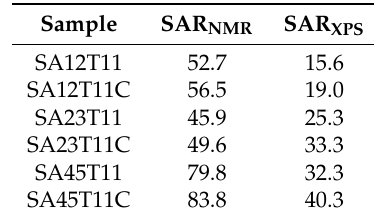
Table 1. SAR calculated using the XPS and HPDEC MAS NMR results of the different Al STF samples (Reprinted from Catalysis Today, v. 2019, P. Vinaches, E. C. Gonçalves, Y. Variani, A. Rojas, E. Rodríguez-Castellón, S. B. C. Pergher, Aluminum introduction on the STF zeolite synthesized with the organic structure-directing agent 123TE4MI, in press, Copyright (2019), with permission from Elsevier